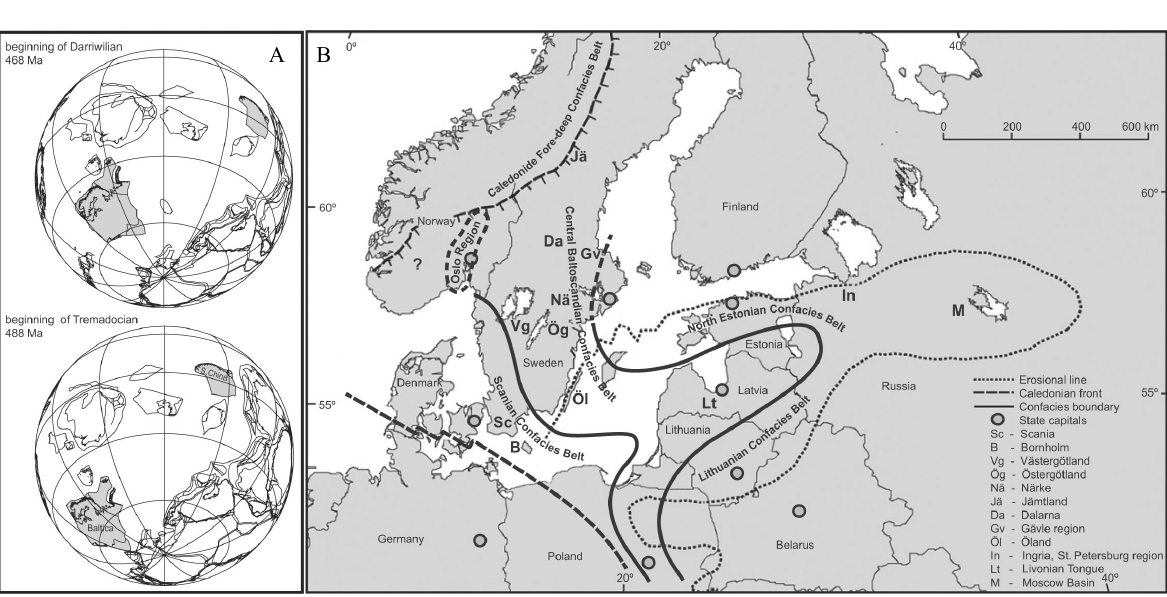
Fig. 2. ( A ) Palaeogeographical position of Baltica during the (cid:214)landian. (Map generated using T. H. Torsvik(cid:146)s GIS-oriented software from 2009, BugPlates: linking biogeography and palaeogeography). ( B ) The confacies (bio-lithofacies) belts of Baltoscandia modified from Jaanusson (1982a). The conventional Oslo Confacies Belt is here considered to be a delimited region of unusual relief rather than an extended belt with intermediate low relief. The Scanian Confacies Belt is thought to bend to the southwest south of the fault-bounded Oslo Region. The basin with shale extending from the Oslo Region north over J(cid:228)mtland according to Hansen (2009, figs 3, 4) and Hansen et al. (2011, fig. 2) is not supported in this reconstruction. The J(cid:228)mtland autochthon has Central Baltoscandian-type limestone from the upper Tremadocian to the middle Darriwilian and clastic sediments occur only in allochthonous rocks transported from the Caledonian area in the west (Jaanusson & Karis 1982, p.